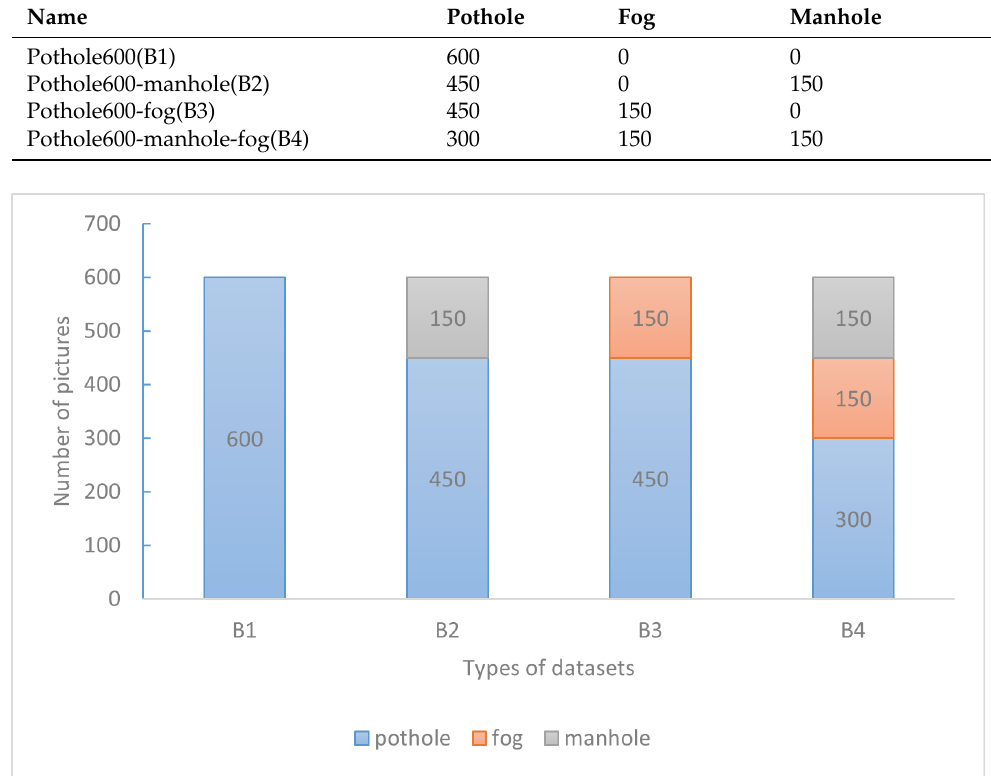
Figure 9. Pothole600 datasets and augmented number of pictures in the